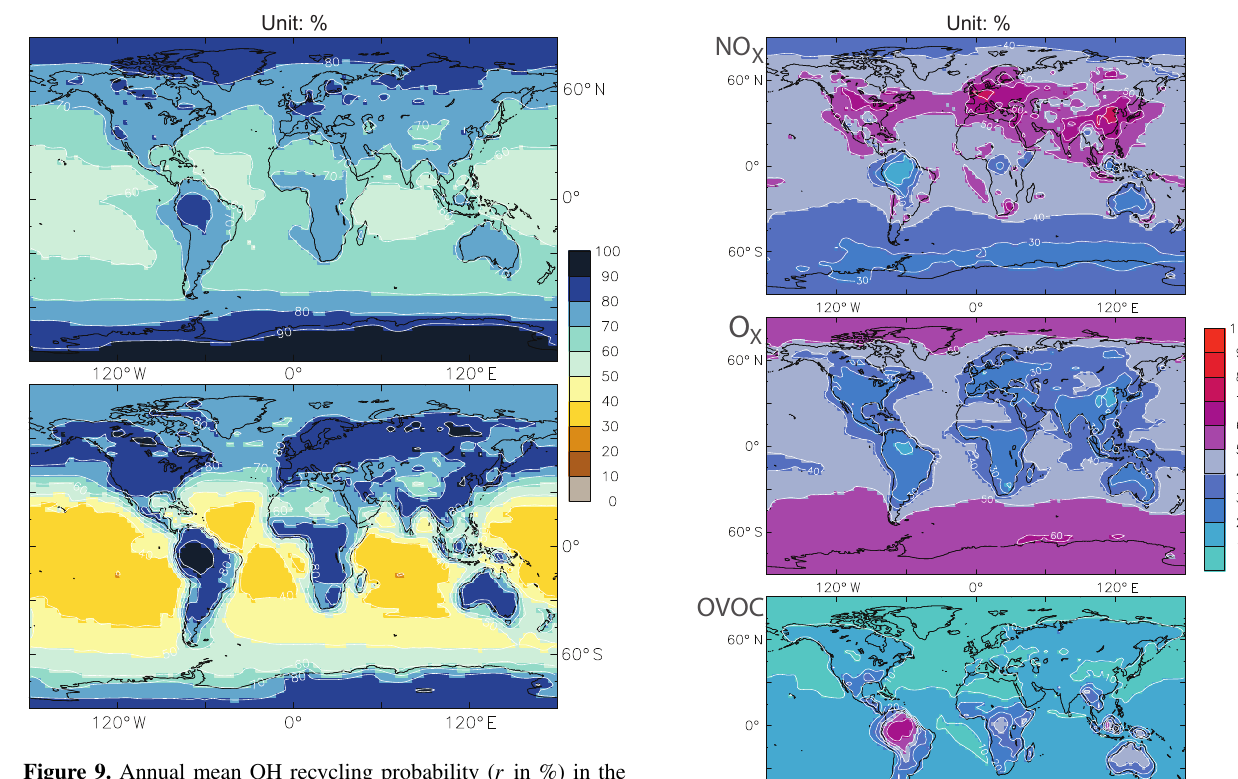
Figure 9. Annual mean OH recycling probability ( r in %) in the troposphere (top) and the BL (bottom).